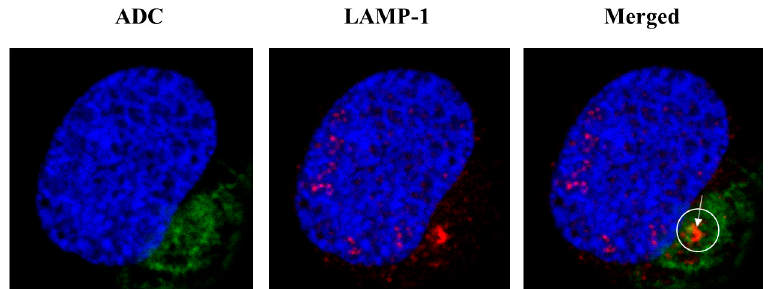
Figure 8. Trafficking and subcellular localization of OFA-GPN-vcMMAE. Daudi cells were treated with OFA-GPN-vcMMAE at 37 °C for 6 h. Cells were fixed, permeabilized, and cell-associated ADC and lysosome-associated membrane protein-1 (LAMP-1) were detected with respective fluorochrome-conjugated secondary antibodies. Nuclei were stained with DAPI (blue). Arrow indicated co-localization of ADC (green) with lysosomes (red).